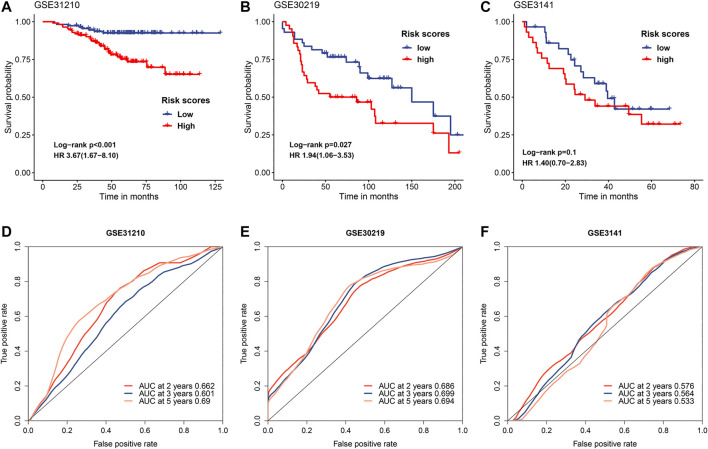
Evaluation of FRRS performance in independent datasets. Kaplan-Meier curves and univariate Cox regression of overall survival in (A) GSE31210, (B) GSE30219, and (C) GSE3141. ROC curve analyses in (D) GSE31210, (E) GSE30219, and (F) GSE3141.